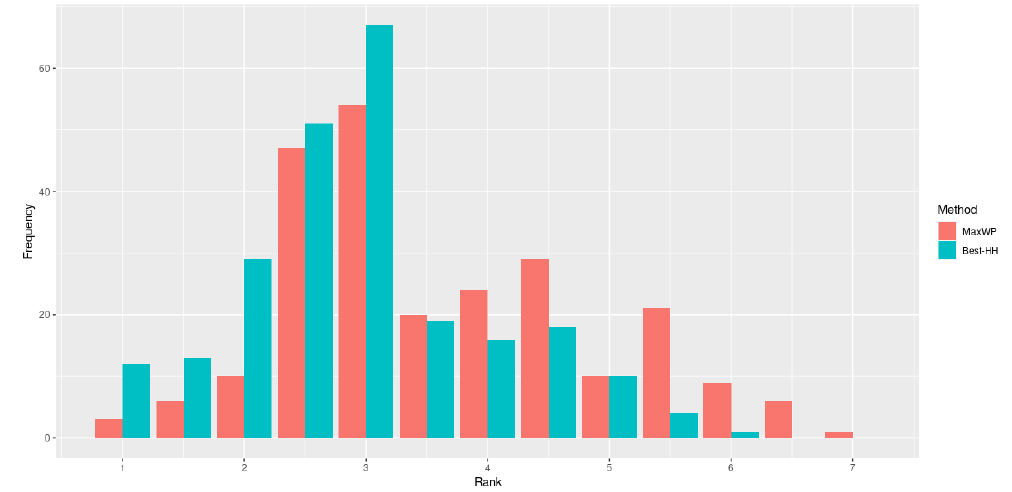
Figure 6. Frequency of the ranks obtained by MaxPW and Best-HH (trained on 60% of set β 1 ) the remaining 40% of set β 1